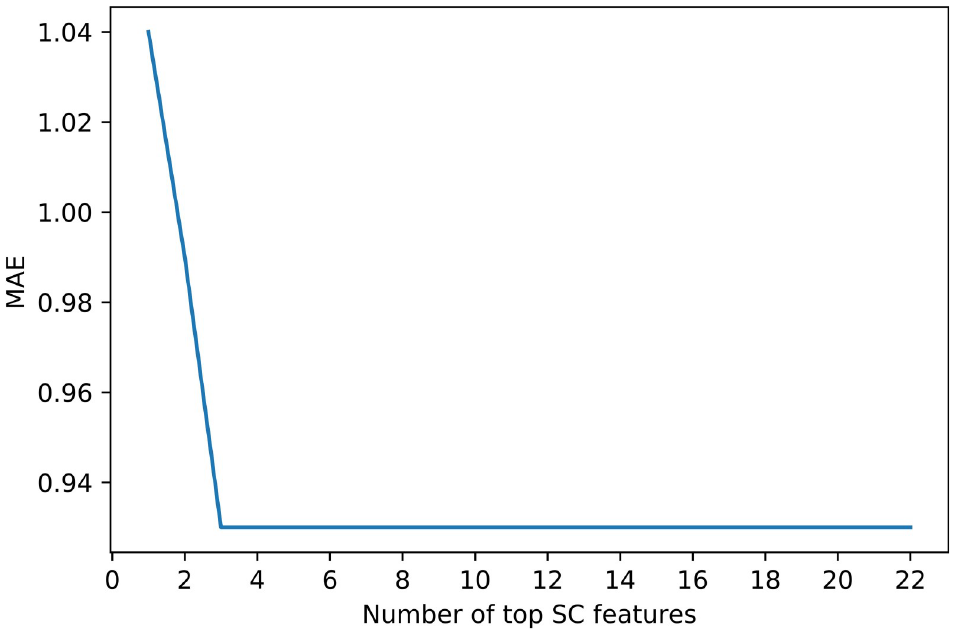
Fig 2. The optimal number of features to be